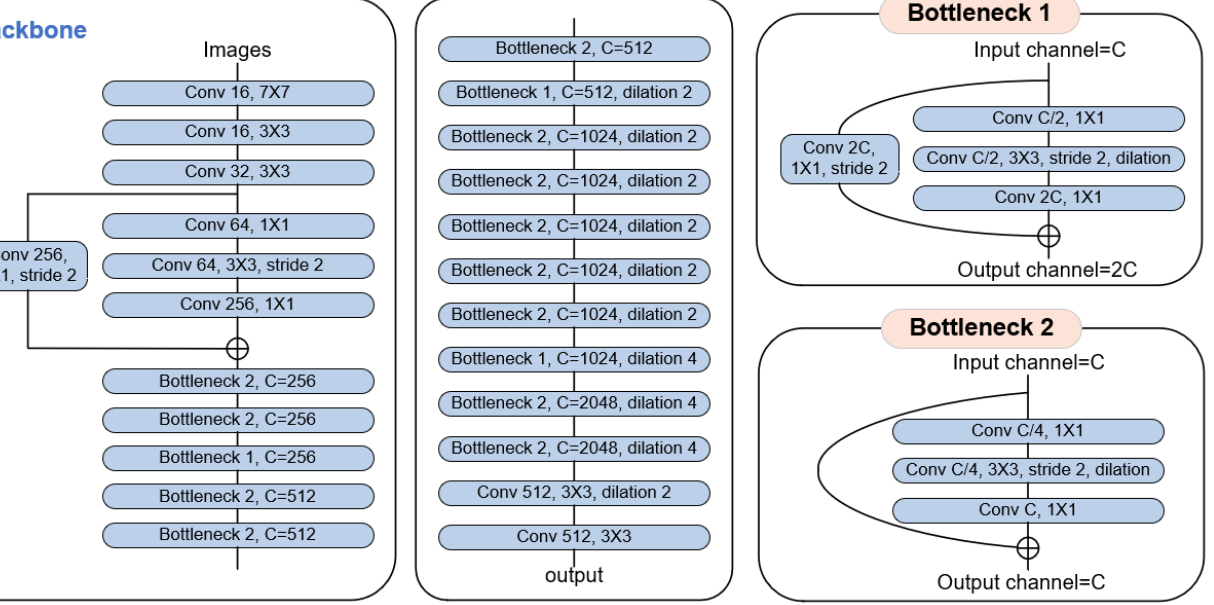
Figure 3. The structure of the network backbone. Each shape represented as a convolutional layer is actually a Conv-BN-ReLU group consisting of a convolutional layer, a BatchNorm layer, and a ReLU activation layer. The stride represents the step of the convolution. Dilation represents the rate adopted by dilated convolution. The letter C denotes the number of channels in the corresponding layer. 1 × 1, 3 × 3, and 7 × 7 are denoted as the kernel size of different convolution kernels.